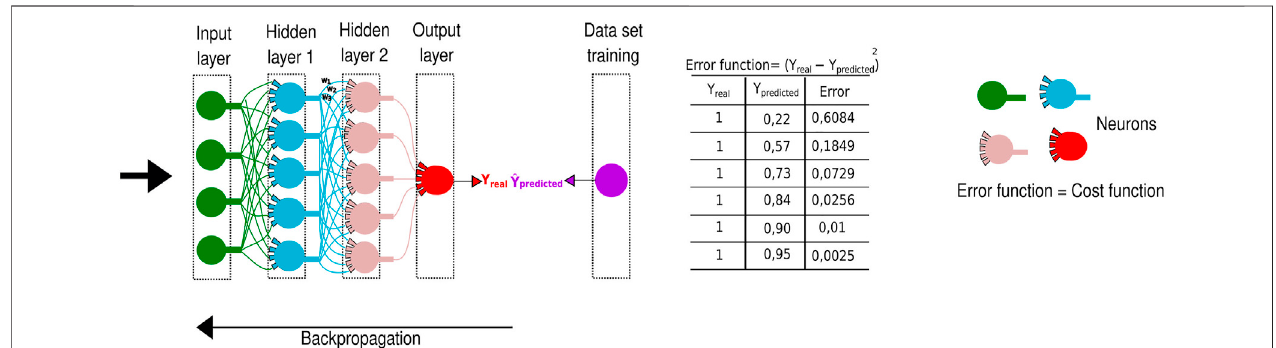
FIGURE 5| Representation of adeep neural network. Itis widely applied in computingsystems, employingschematic neurons to demonstrate the signal passage throughdifferentlayers.Thepredicted valuenamed ŷ isobtainedinthe fi nallayer.Thisvaluewillbedecreasedfromtherealyvalue,and theresultwillcomprisetheerror, of what was lost along the neural network. The process is repeated until the smallest possible error is reached through a backpropagation algorithm.